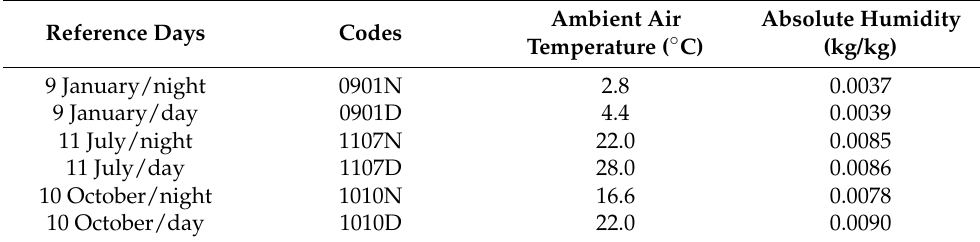
Figure 2. Monthly average temperature distribution of the ambient air and air after SW (bars indicating the minimum and maximum deviations). Table 3. Selected representative reference days for the Aspen Plus simulations together with ambient air temperatures and absolute humidity.